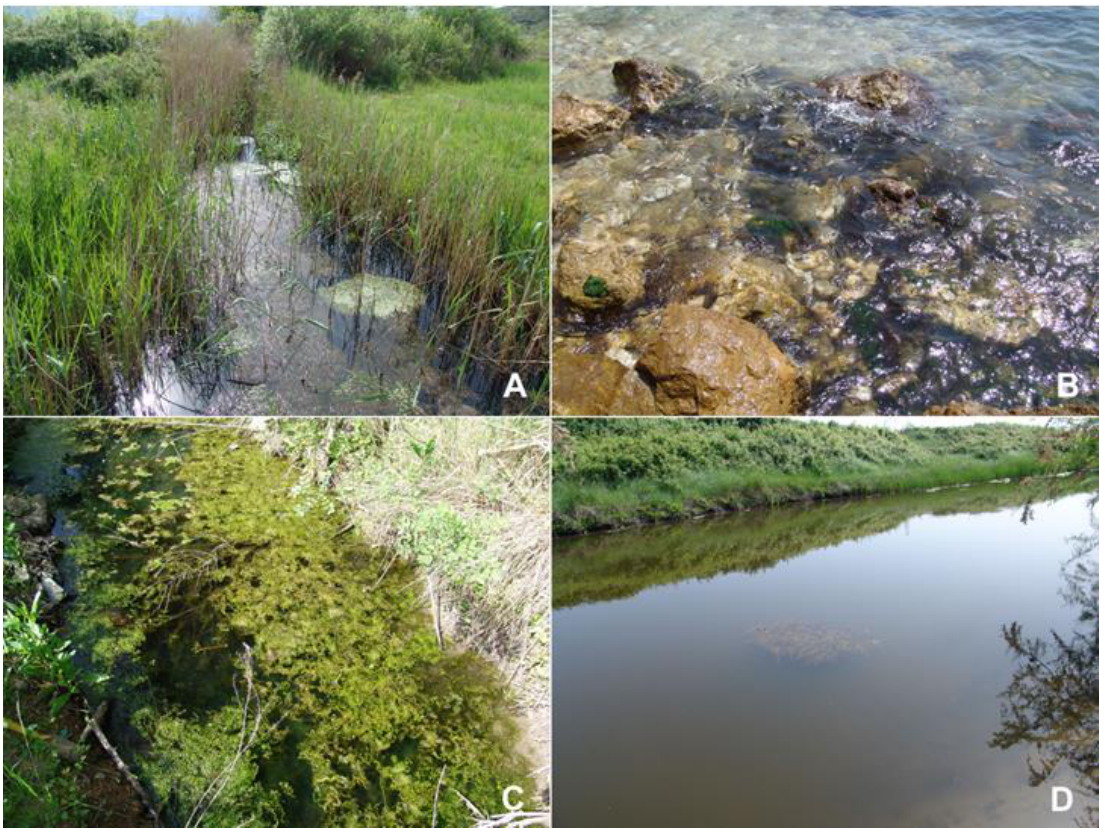
Figure 2. Landscape views showing of the sampling sites of Ulva pilifera : ( A ) the river (freshwater), mass growth of the green thallus of Ulva ; ( B ) a rocky cliff on large rocks of the Adriatic Sea (marine); ( C ) the ditch (freshwater); ( D ) the Milet Canal (freshwater).